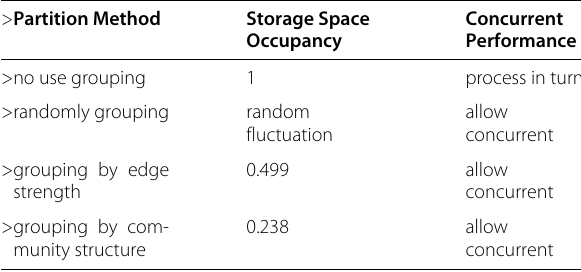
Table 2 Performance comparison of different blockchain partition